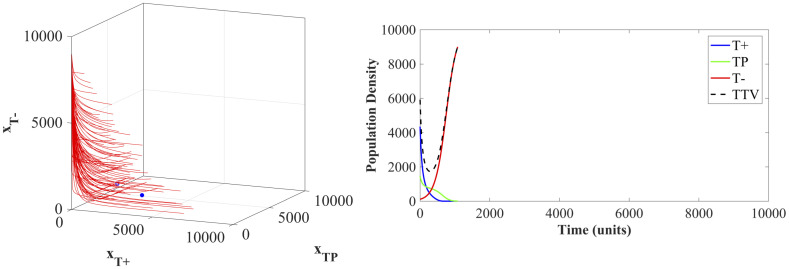
Maximum tolerable dose state dynamics.State trajectories for 100 initial tumor compositions (left panel), used for optimization of patients under the maximum tolerated dose protocol. All state trajectories end when the total tumor burden violates the patient viability constraint (5). The two blue dots show the location of the two equilibria (two- and three- species). The right panel shows the population densities of the three cell types in a representative case.